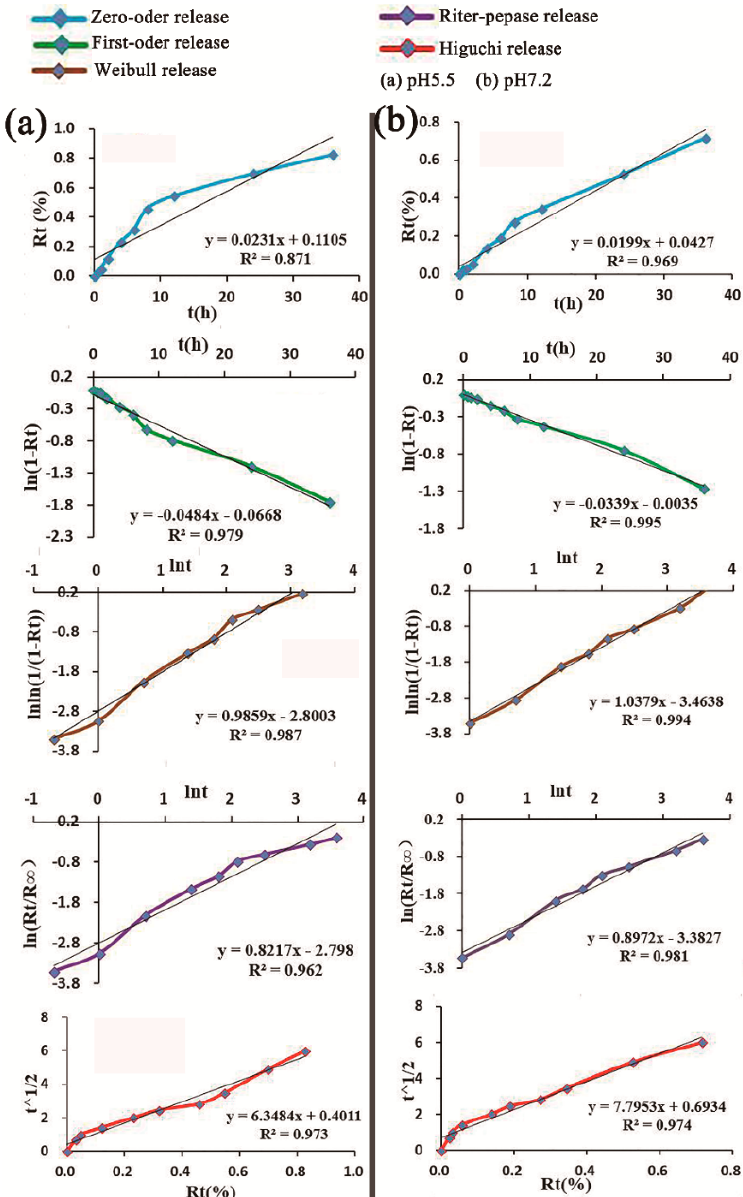
Figure 6. Fitting curve by different mathematical models under different pH values: ( a ) pH = 5.5 and ( b ) pH = 7.2, Rt = accumulated release rat.